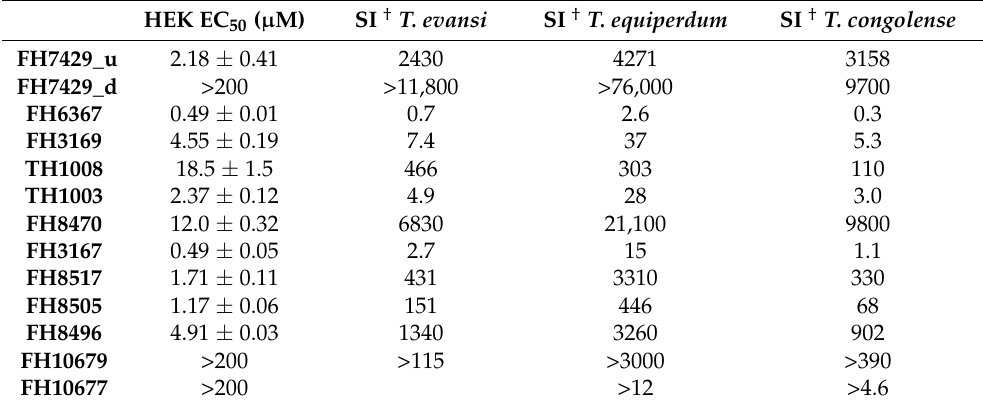
Table 9. Toxicity of tubercidin analogs with substitutions on C7 against human embryonic kidney (HEK) cells. HEK EC 50 ( µ M) SI † T. evansi SI † T. equiperdum SI † T. congolense FH7429_u 2.18 ± 0.41 2430 4271 3158 FH7429_d >200 >11,800 >76,000 9700 FH6367 0.49 ± 0.01 0.7 2.6 0.3 FH3169 4.55 ± 0.19